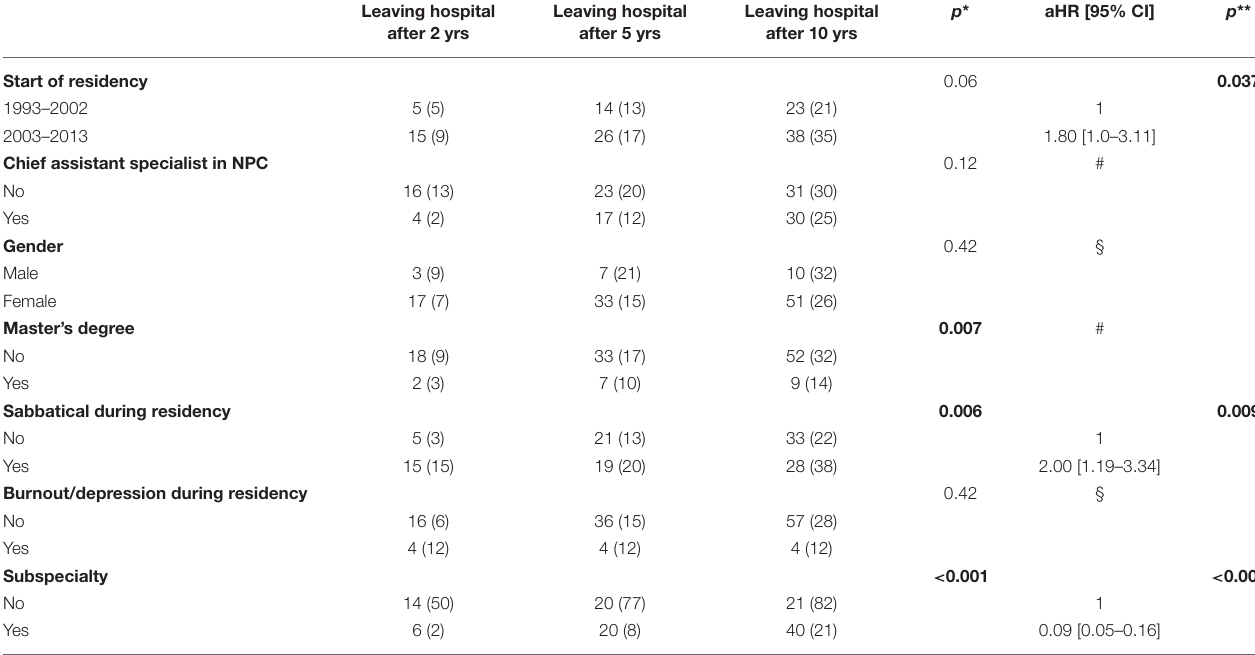
p * aHR [95% CI] p ** Leaving hospital Leaving hospital Leaving hospital after 2 yrs after 5 yrs after 10 yrs